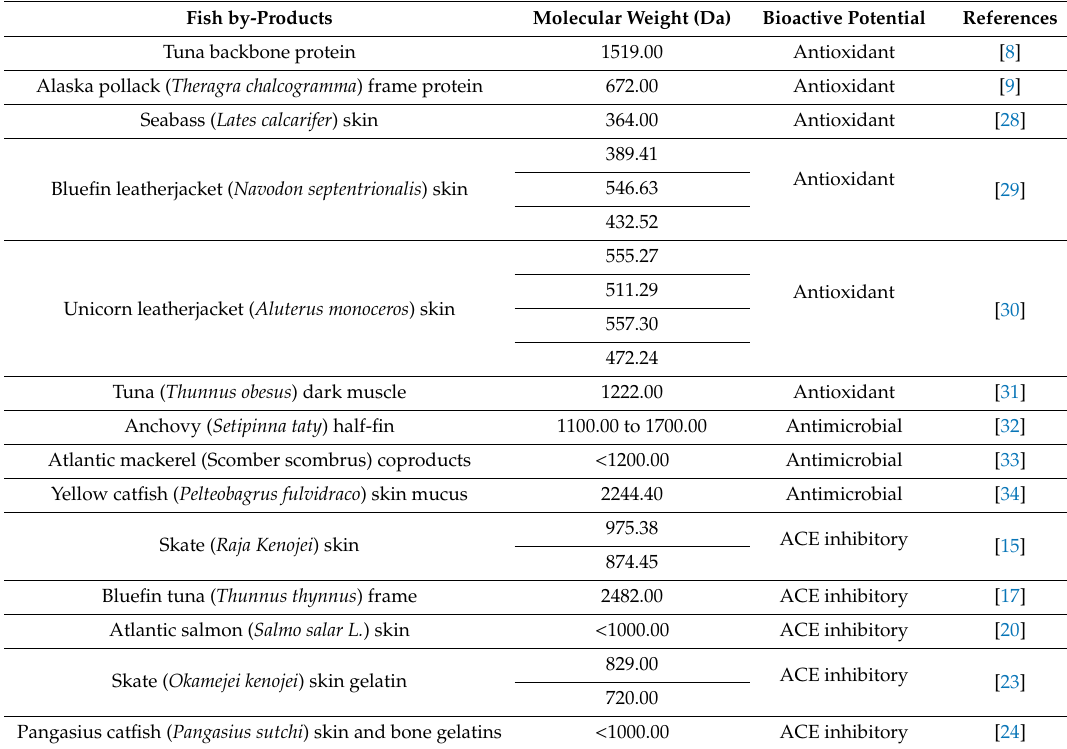
Table 1. Biopeptides from fish by-products with antioxidant, antimicrobial, and ACE inhibitory